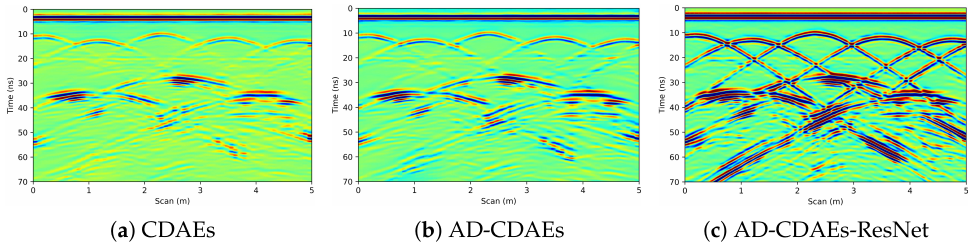
Figure 10. Noise attenuation result for the GPR profile of the tunnel lining.